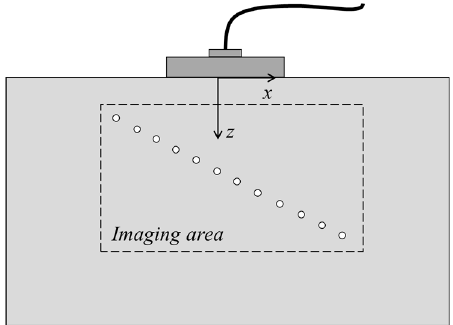
Table 1. Array parameters in the simulation and experiment.